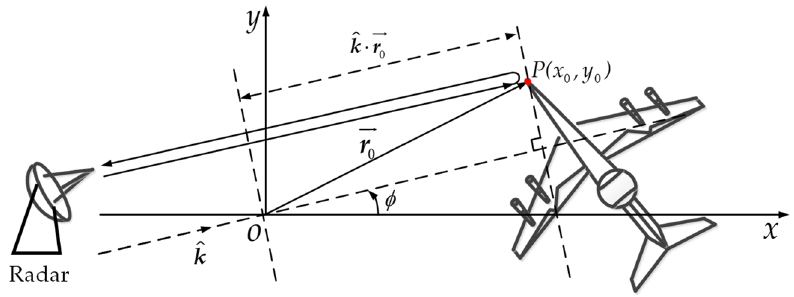
Figure 1. ISAR imaging model.